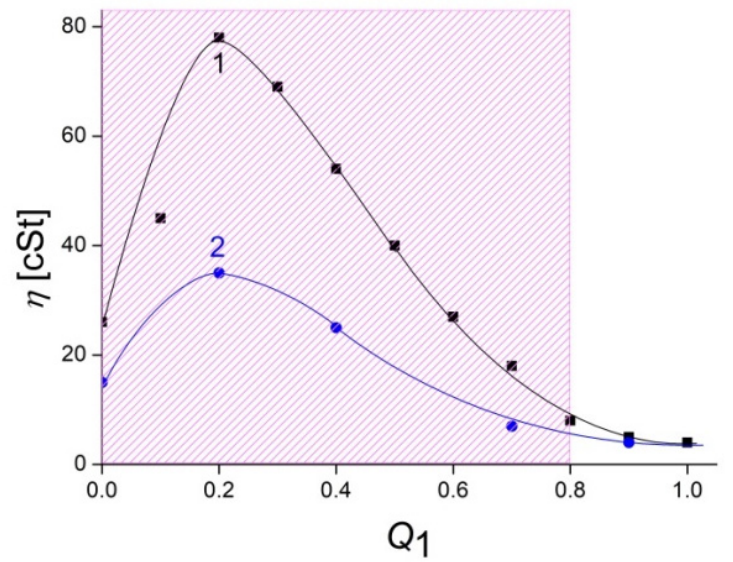
Figure 3. Kinematic viscosity ( η ) of IPEC solutions vs. Q 1 = [ALG]/[QHECE]. [QHECE] = 1.5 × 10 –2 M; 10 –2 M phosphate buffer of ( 1 ) pH 7 and ( 2 ) pH 10. The cross-hatched region represents water- soluble IPECs.